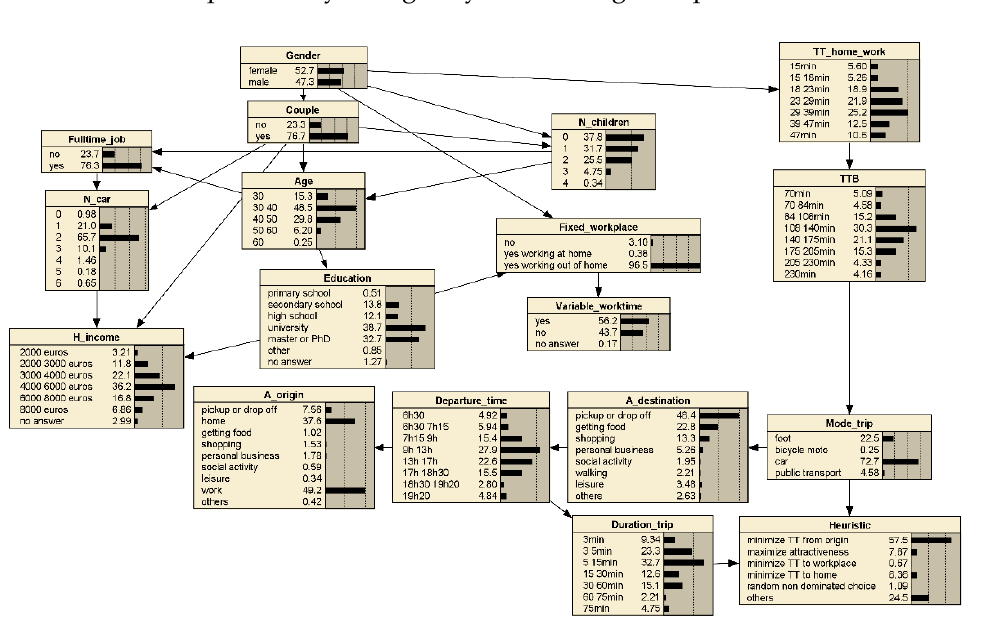
Figure 6. Marginal probability tables of the Bayesian network based on the Hill-Climbing algorithm with Set 2 structural